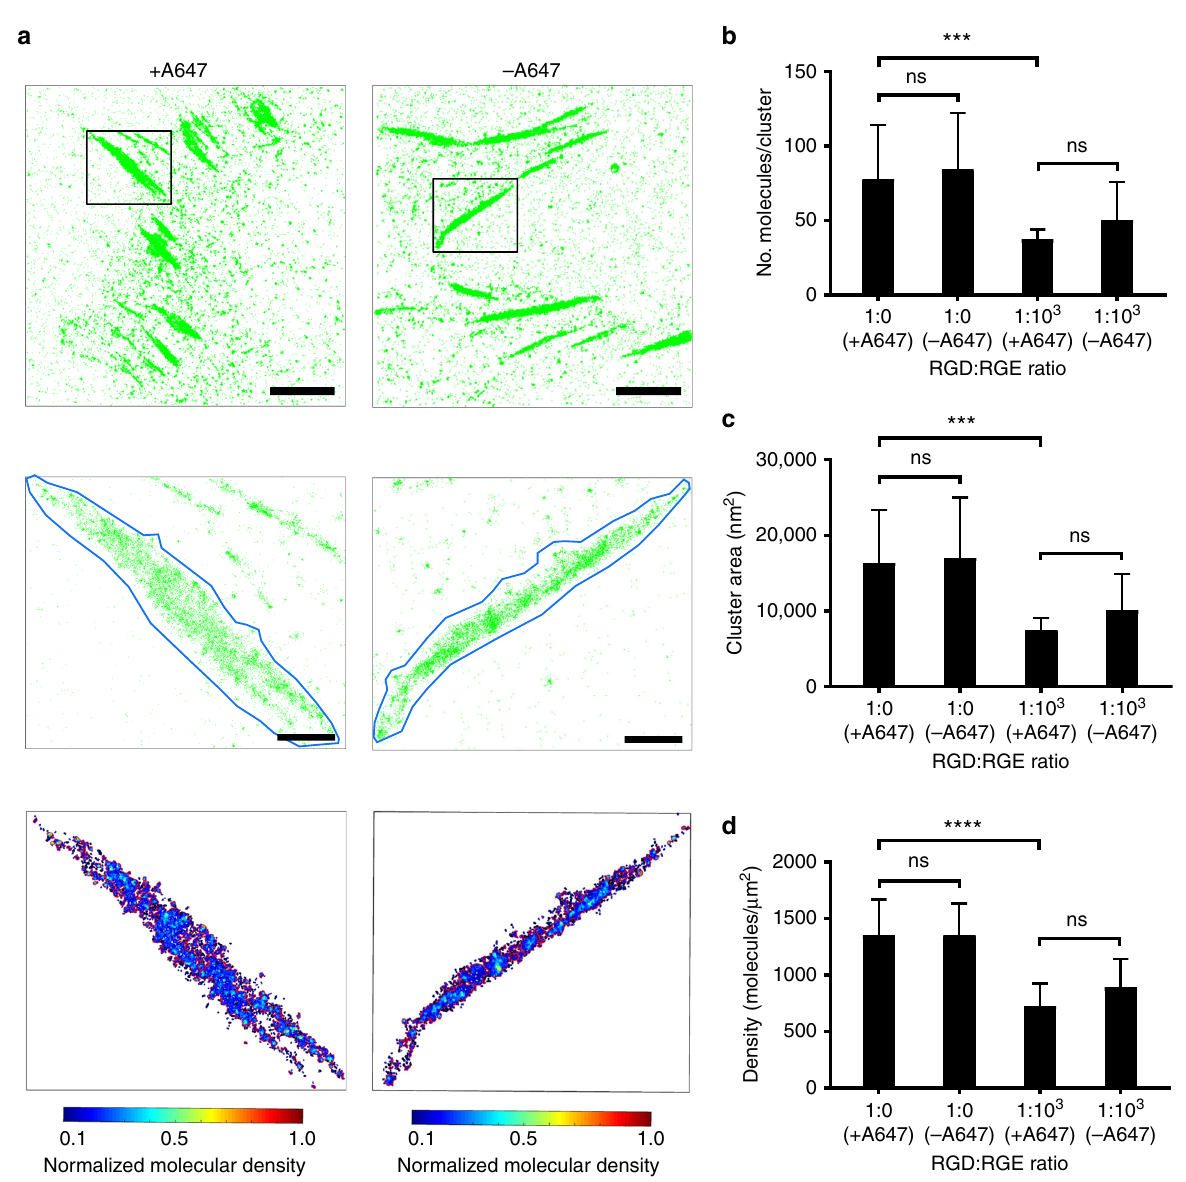
Fig. 3 Paxillin-mEos2 clusters on RGD-A647- and RGD-functionalised ITO surfaces. a PALM images of paxillin-mEos2 in NIH-3T3 cells adhering onto ITO surfaces that were functionalised with RGD-A647 (left) and unlabelled RGD (right). Top: PALM images of paxillin-mEos2; scale bar = 5 µ m. Middle: zoomed regions (black boxes in top row) of an individual adhesive structure with the region for analysis traced (blue line); scale bar = 1 µ m. Bottom: paxillin-mEos2 clusters inside identi fi ed adhesive structures; colours indicated molecular densities. Images are representative images of n = 3 − 5 independent experiments. b Number of paxillin-mEos2 in clusters, c cluster area, and d density of paxillin-mEos2 molecules inside adhesive structures in NIH-3T3 cells on ITO surfaces with 1:0 and 1:10 3 of RGD-A647:RGE or RGD:RGE. Paxillin-mEos2 clustering inside adhesive structures was dependent on the RGD density on the surface, but not affected by A647 fl uorophore labelled on RGD peptides; ns not signi fi cant ( P > 0.05), *** P < 0.001 and **** P < 0.0001 (two-way ANOVA with Tukey post-testing). Bars and error bars are mean and standard deviation, respectively, n = 3 − 5 independent experiments (including 16 − 27 independent regions of